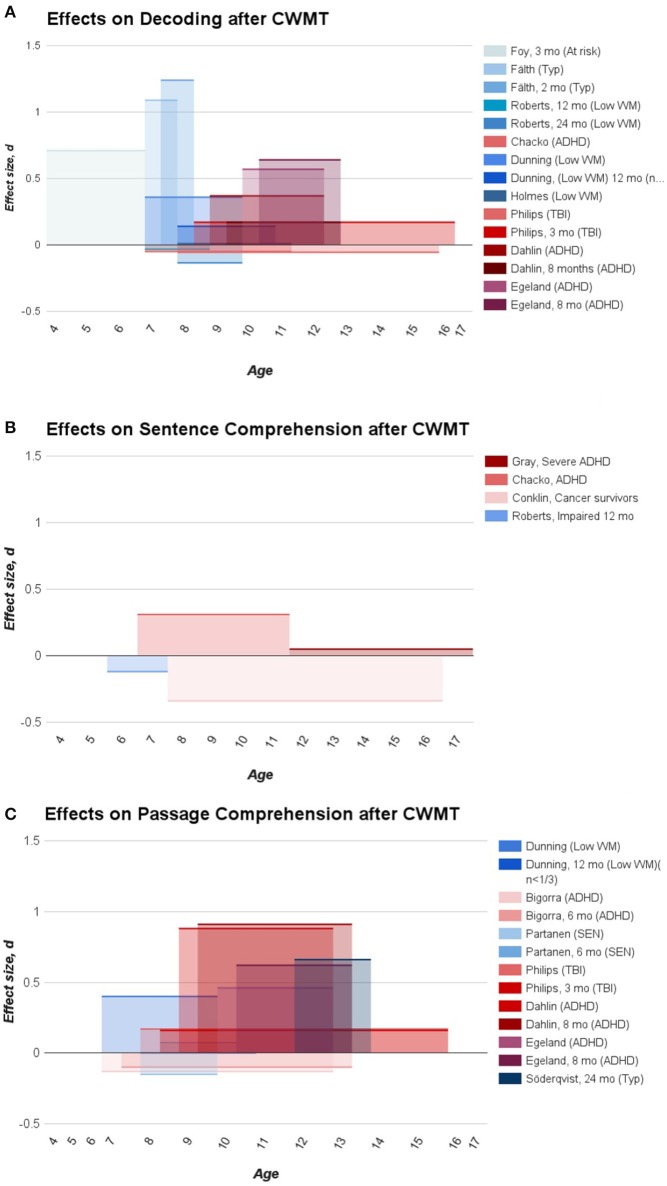
Depicts the effect sizes (Cohen's d) extracted from the studies using CWMT divided between outcomes of decoding (A), sentence comprehension (B), and passage comprehension (C). Studies with clinical samples are color coded in a red shade whereas studies with samples without a clinical diagnosis are depicted in a blue shade.